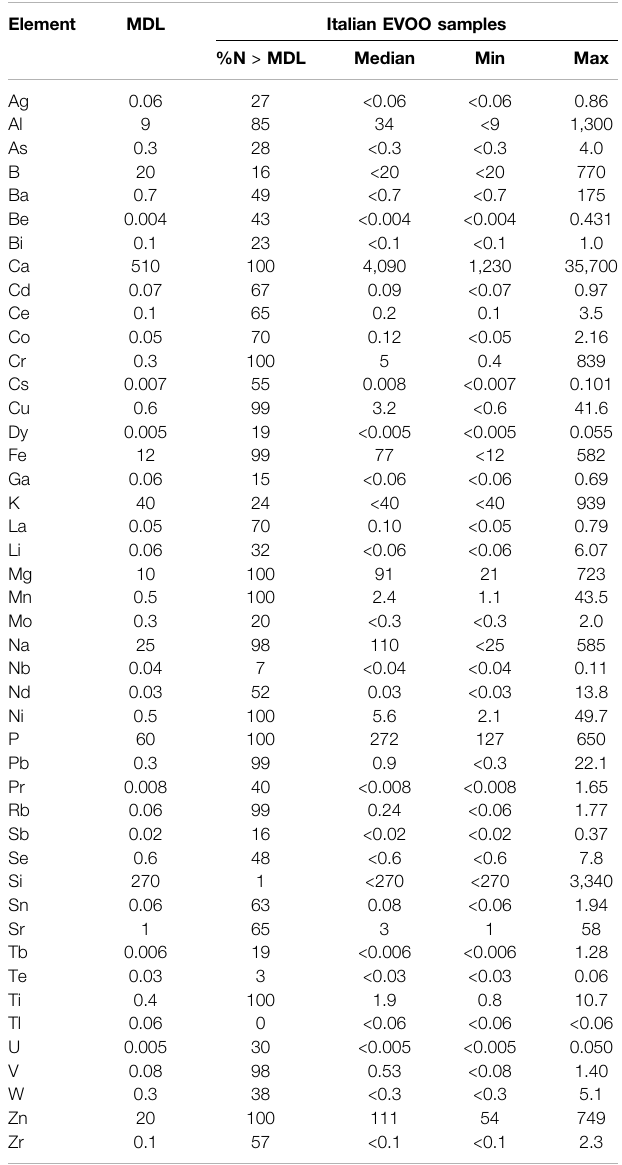
TABLE 2 | Method detection limits (MDL; μ g kg − 1 ) and element levels [median, minimum (min) and maximum (max); μ g kg − 1 ] in extra-virgin olive oils (EVOO; n (cid:1) 237) from all over